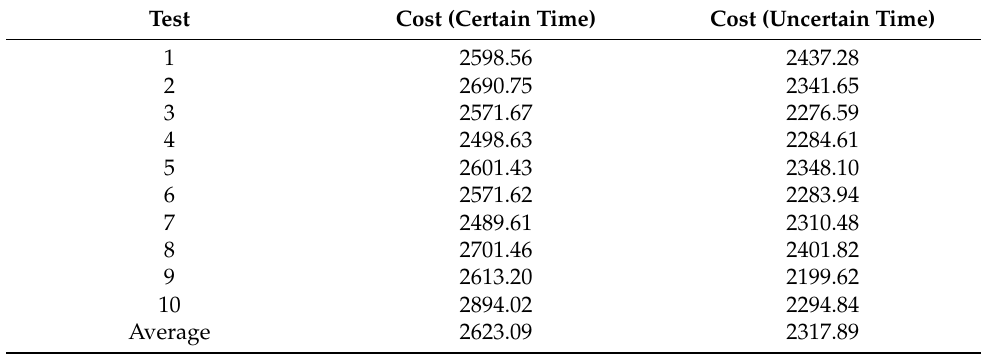
Table 5. Simulation results of R101.